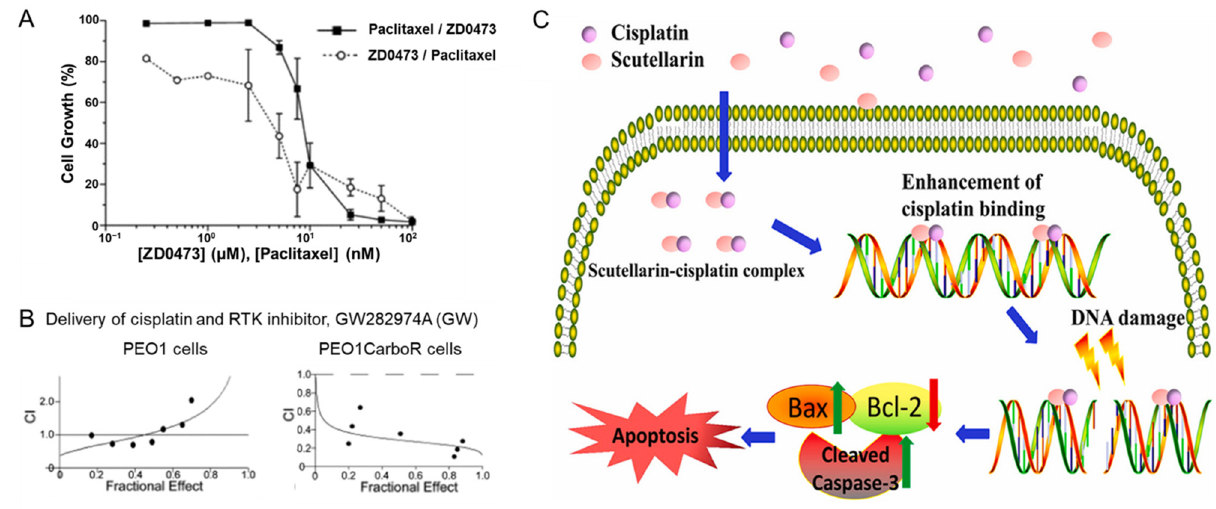
Figure 3. ( A ) Dose-response curve shows sequence-dependent response of sequentially delivering a platinum drug, ZD0473 and paclitaxel in in platinum resistant cells, A2780cis. The results show that delivering platinum drug followed by paclitaxel exhibits greater reduction in cell growth. Reprinted from [45], Copyright 2002, with permission from Elsevier. ( B ) Combination index analysis of cisplatin and a RTK inhibitor, GW282974A (GW), comparing PEO1 and platinum- resistant cells, PEO1CarboR cells showing synergy ( CI < 1) depends on drug concentration and cell type Reprinted from [46], Copyright 2006, with permission from Elsevier. ( C ) Overview of enhanced apoptosis in ovarian cancer cells due to combination treatment of scutellarin and cisplatin. Specifically, the combination treatment increases the ability of cisplatin to bind to DNA resulting in increased the level of cleaved capsase-3 and increased the ratio of Bax/Bcl-2 which promote apoptosis. Overall the result of the drug combination is synergistic ( CI 0.566–0.796 depending on drug ratio) Reprinted from [47]. Copyright 2019, with permission from